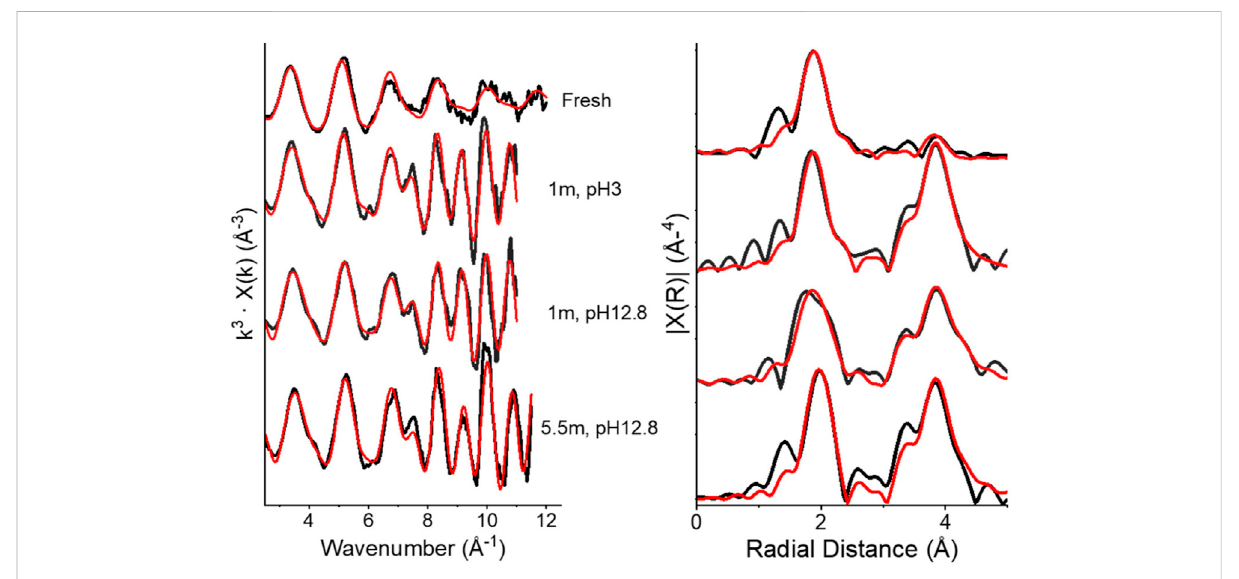
FIGURE 4 EXAFS (left) and Fourier-Transformed EXAFS (right) for (from top to bottom) ThO 2 (s, hyd) freshlyprecipitated, ThO 2 (s, hyd) aged, t = 1 m,pH m = 3, ThO 2 (s, hyd) aged, t = 1 m, pH m = 12.8 and ThO 2 (s, hyd) aged, t = 5.5 m, pH m = 12.8. Black lines are experimental data and red lines are fi